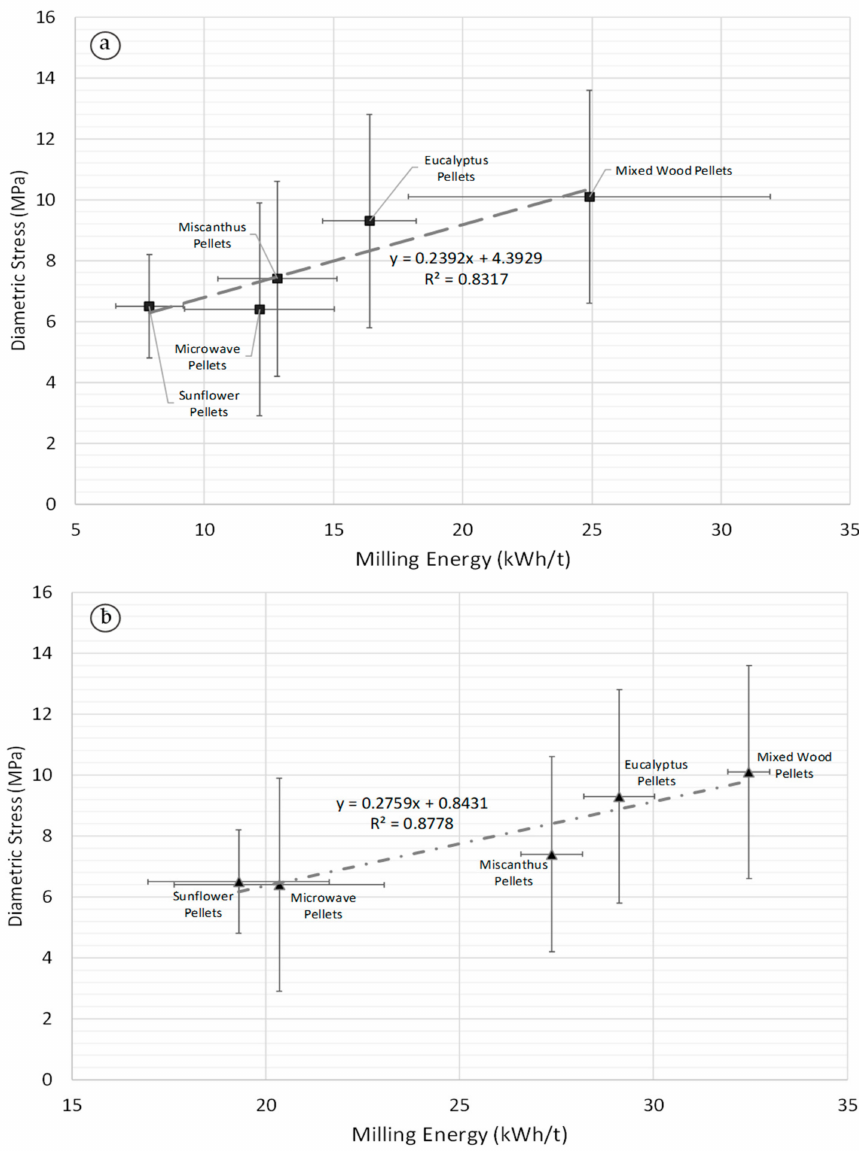
Figure 7. Ring-Roller ( a ) and knife mill ( b ) energy against biomass pellet diametral ultimate strength (milling energy n = 3, stress data n =